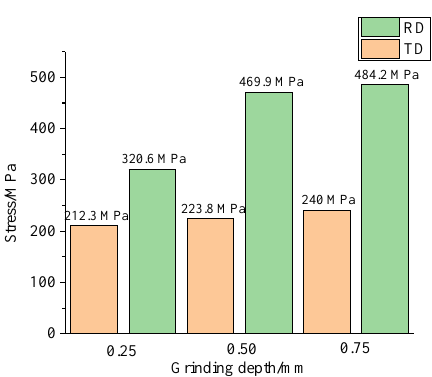
Figure 9. Maximum values of TD and RD stresses of pit center during the first pass deformation zone.